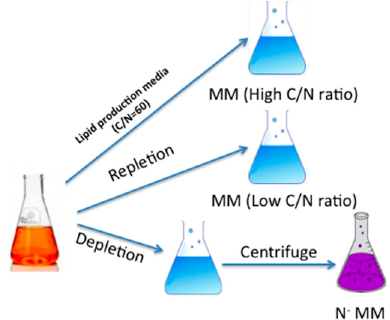
Figure 5. Experiment design to test the effect of nitrogen depletion on lipid production in Trichoderma reesei and Yarrowia lipolytica